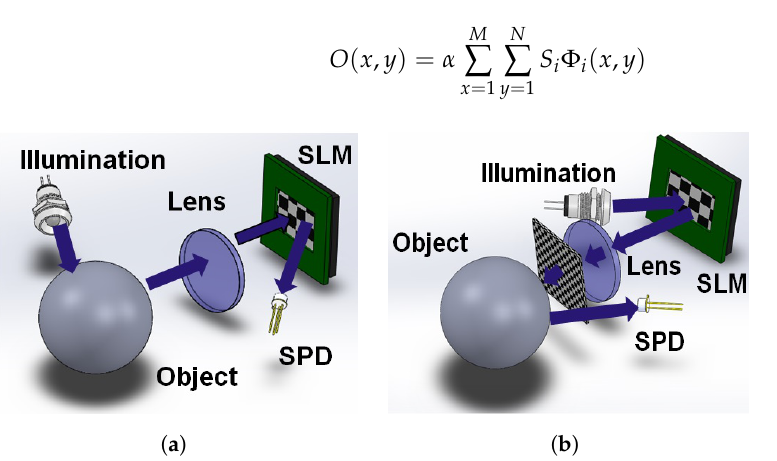
Figure 1. Two Different configurations for SPI: ( a ) Structured detection: the object illuminated by a light source and the light reflected by it gets directed through a lens onto an SLM, and captured by the SPD, ( b ) Structured illumination: the SLM device projects a sequence of patterns on the object and reflected light that is captured by the SPD. Representation of SPI based on published